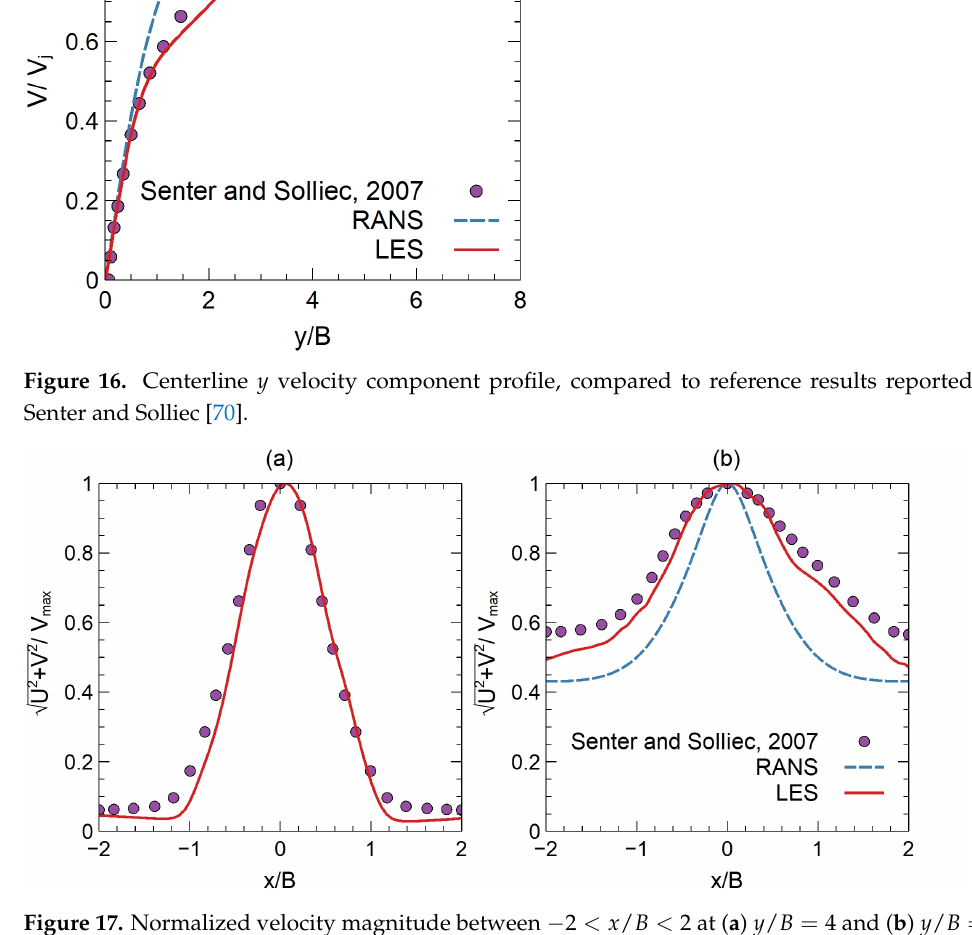
Figure 17. Normalized velocity magnitude between − 2 < x / B < 2 at ( a ) y / B = 4 and ( b ) y / B = 1, compared to reference results reported by Senter and Solliec